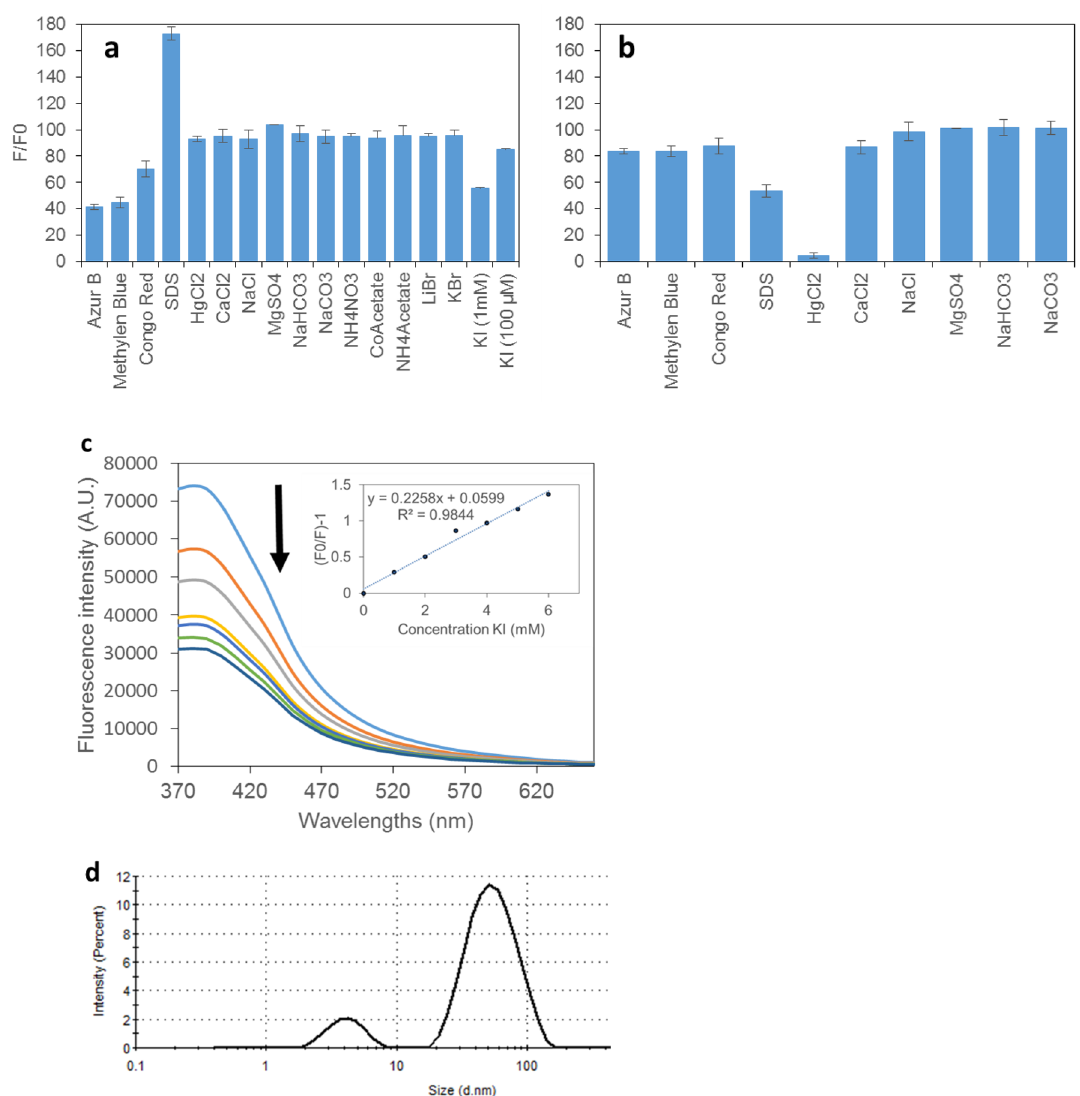
Figure 5. The fluorescence response of Phe-AuNCs ( a ), and BSA-AuNCs ( b ) to various substances, and the sensitivity of Phe-AuNC to KI ( c ). The size of the PheAuNC after adding KI. Shows the decrease of the size to very small to 34